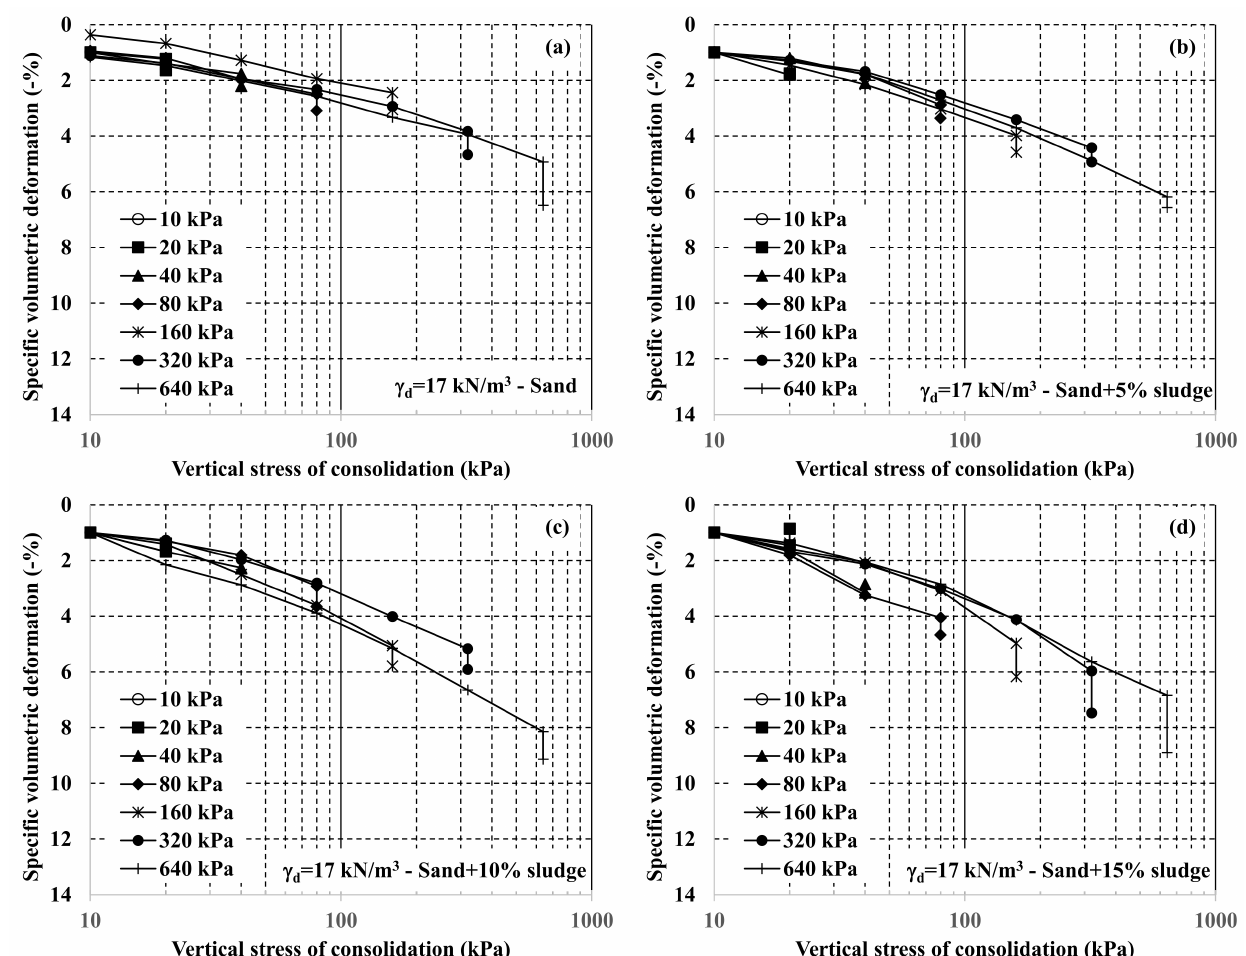
Figure 9. Variation of specific volumetric deformation with the vertical consolidation stress obtained through single oedometer tests, for dry apparent specific weight of 17.0 kN/m 3 : ( a ) sand, ( b ) sand plus 5% sewage sludge, ( c ) sand plus 10% sludge, ( d ) sand plus 15% sludge.